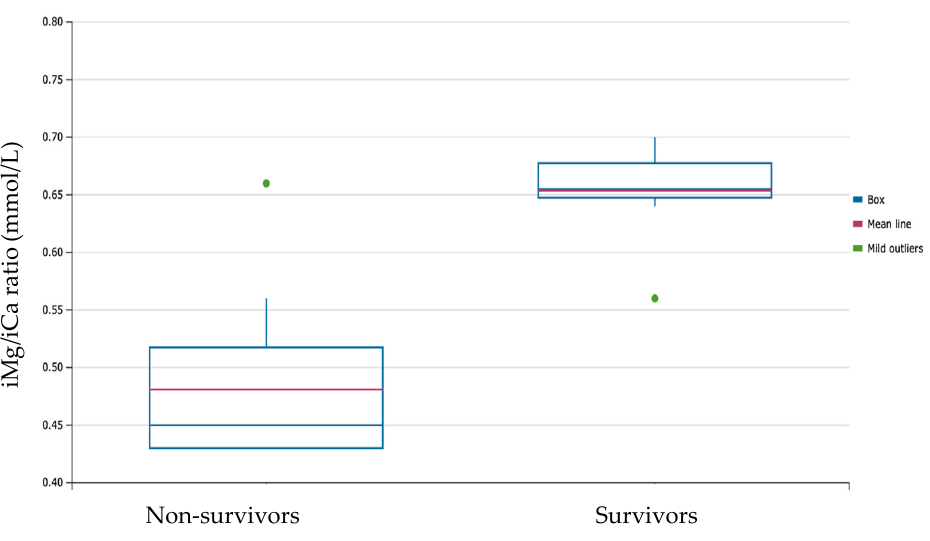
Figure 1. Box Plot iMg/iCa ratio by outcome.